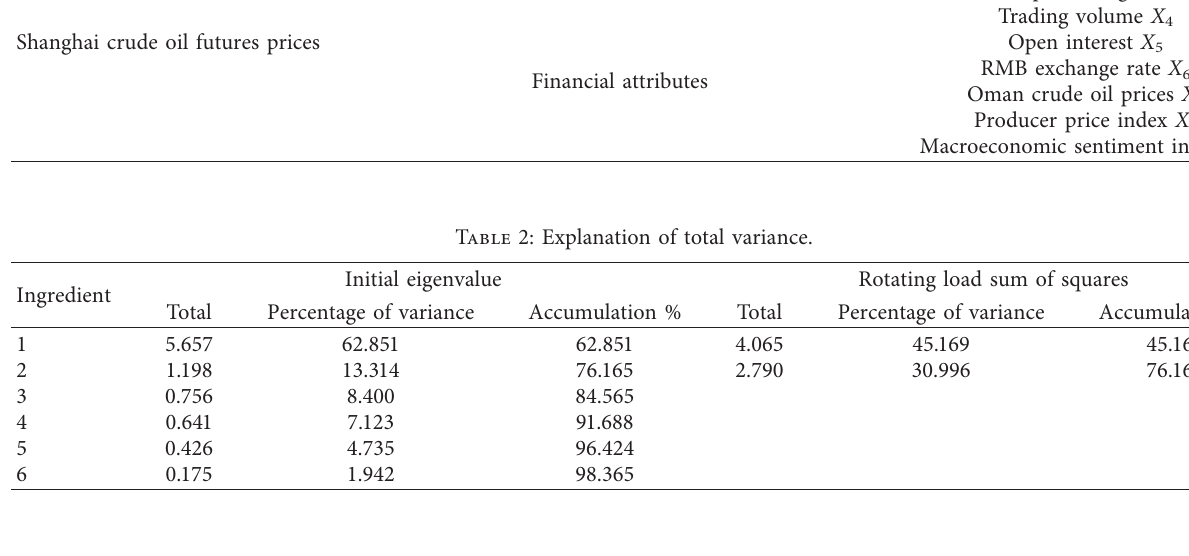
Table 3: Component score coefficient matrix.